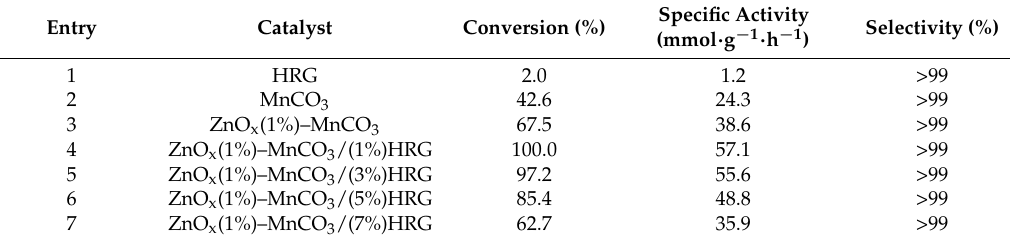
Table 2. Catalytic results of various catalysts in the selective oxidation of benzyl alcohol.